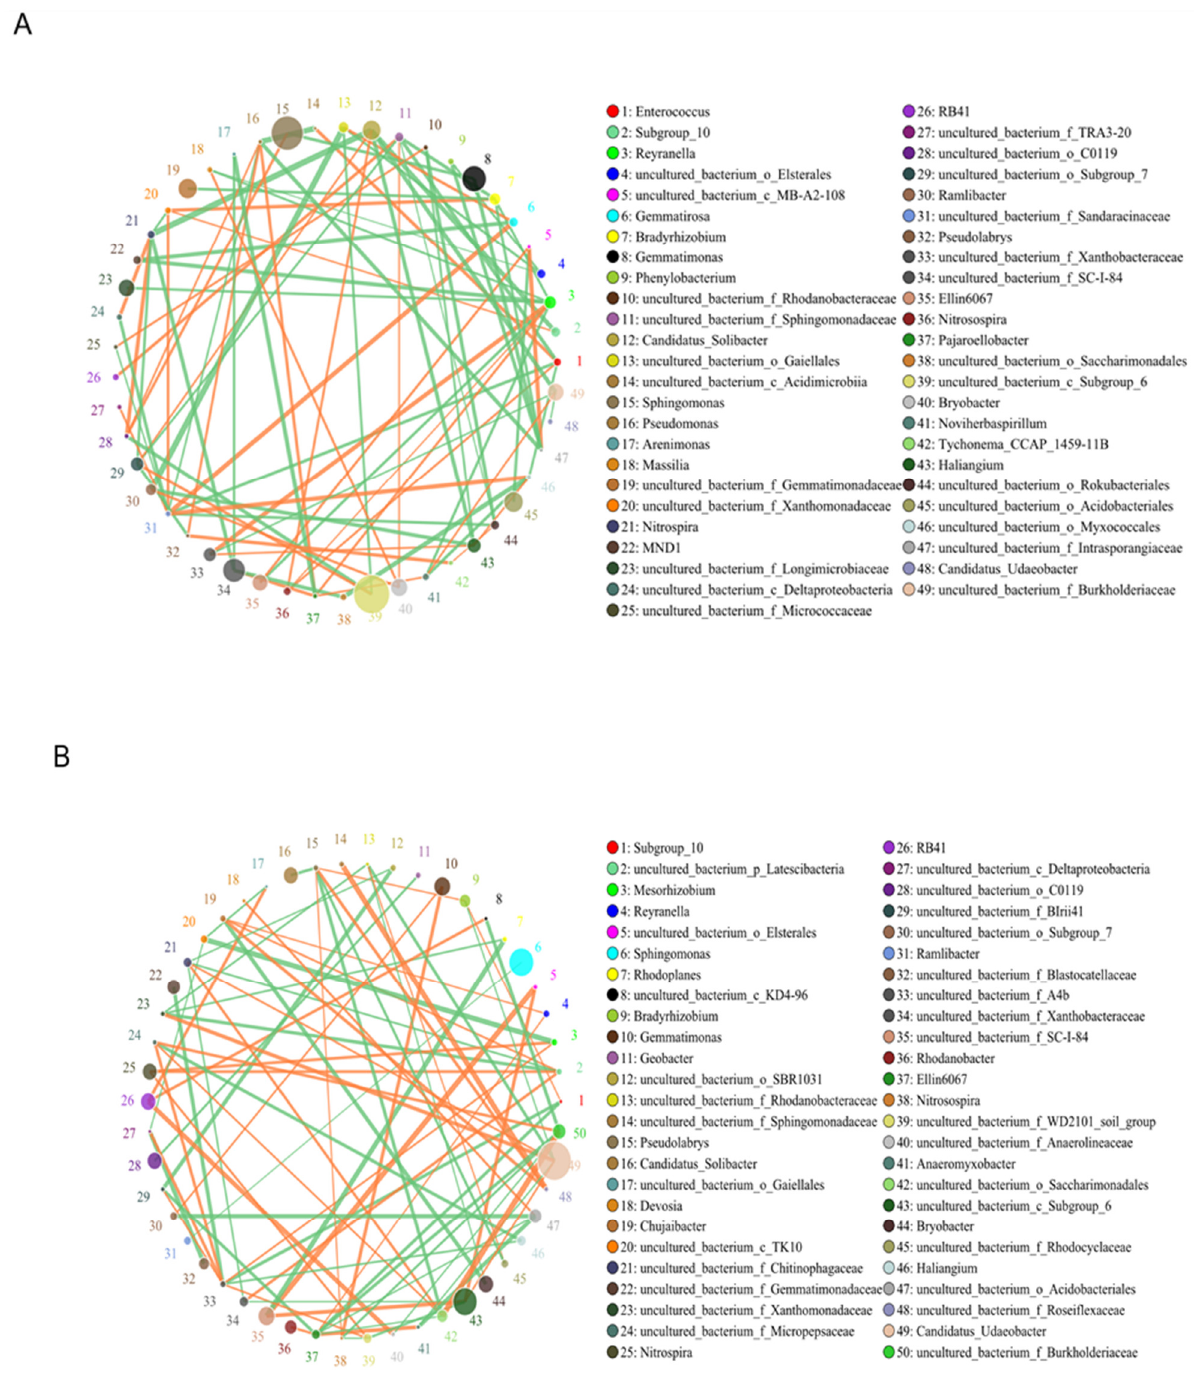
Figure 6. CK ( A ) and BC ( B ) bacterial community species network diagram. CK, conventional fertilizer; BC, biochar with conventional fertilizer. Each node represents each dominant phylum and is identified by a different color. The edge connecting two nodes indicates the correlation between two phyla, with the orange line indicating a positive correlation, and the green line indicating a negative correlation. The node size indicates the degree of association between the g phyla and other phyla of the community. The node size increases with the degree. Different colors represent different degrees of